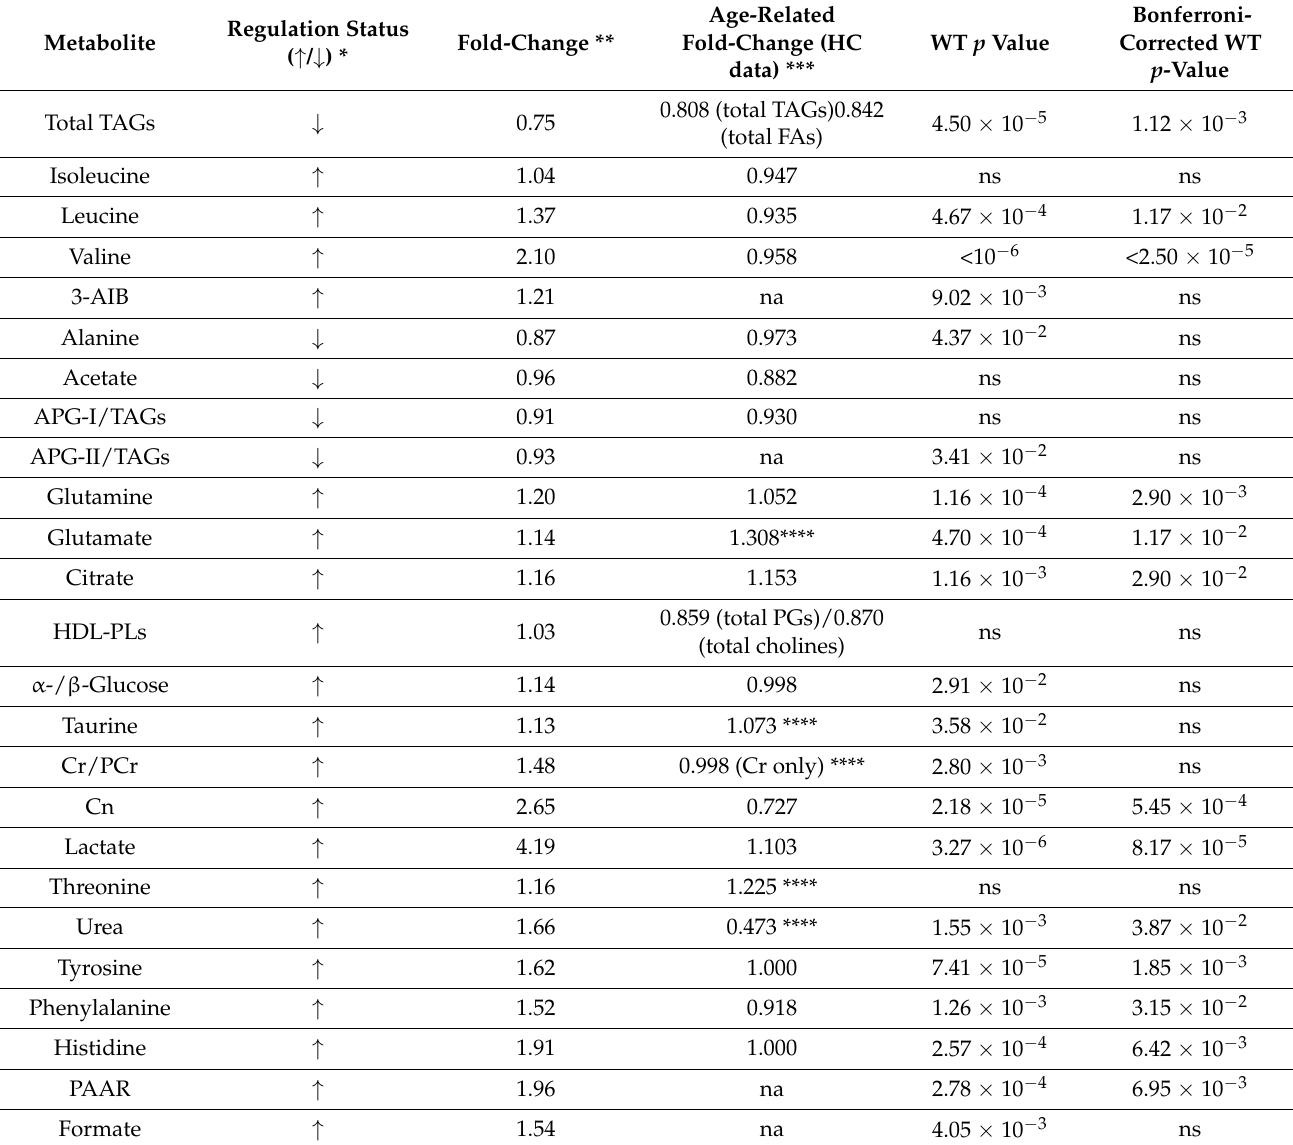
Table 2. Statistical significance and nature of differences between the 1 H NMR-detectable plasma metabolite levels (as 1 H NMR resonance intensity equivalents) of GM1T2 and HC